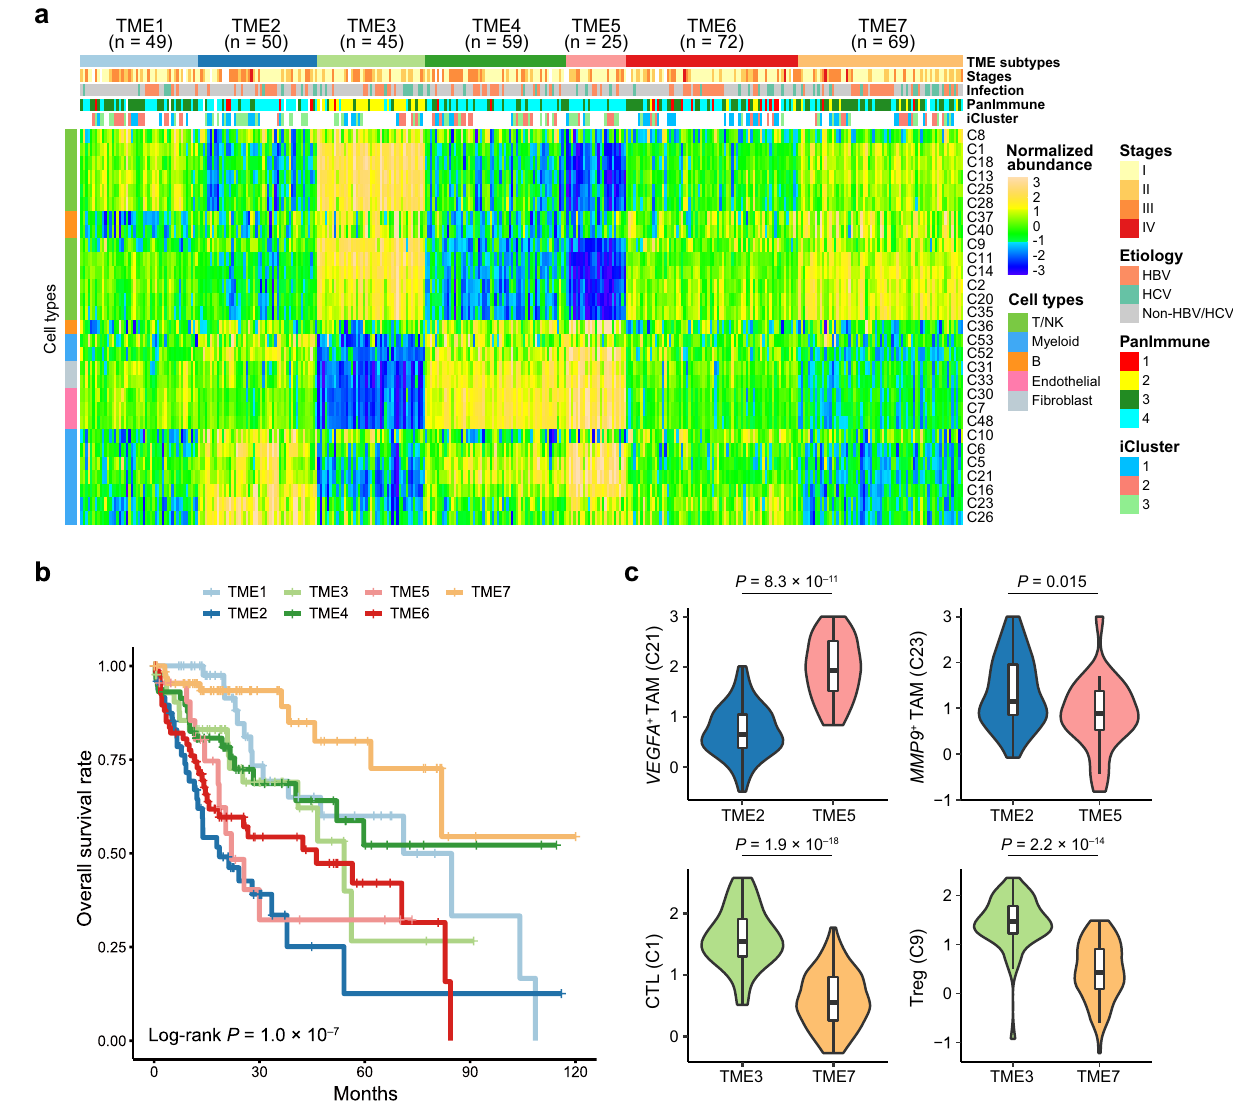
Fig. 7 | Bulktissue celltype deconvolution analysis shows sevenTME subtypes of HCC. a Heatmap showing seven tumor microenvironment (TME) subtypes of HCC patients (TME1 – 7) with distinct composition of immune and stromal cell subtypes inferred from bulk RNA-seq data of the TCGA-LIHC cohort. Rows repre- sent the 29 patient-shared immune and stromal cell subtypes identi fi ed by the scRNA-seq data in this study. Columns represent the 369 HCC patients from the TCGA-LIHC cohort. Tumor-node-metastasis (TNM) stages, etiology, PanImmune subtypes and iCluster subtypes are annotated by colors at the top of the heatmap. b Kaplan – Meier survival analysis shows that the seven TME subtypes exhibit